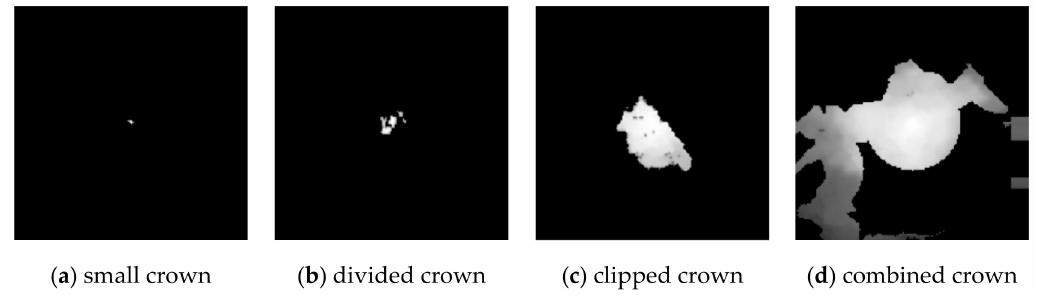
Figure 16. Crown images with abnormal shape. The pixel value of each image indicates estimated tree height. The spatial size of each image is 161 × 161 pixels and one pixel represents 10 × 10